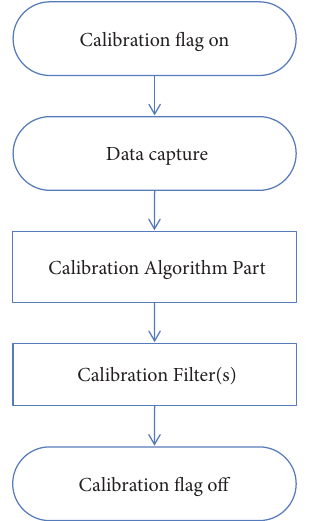
Figure 2: Flowchart for the Calibration